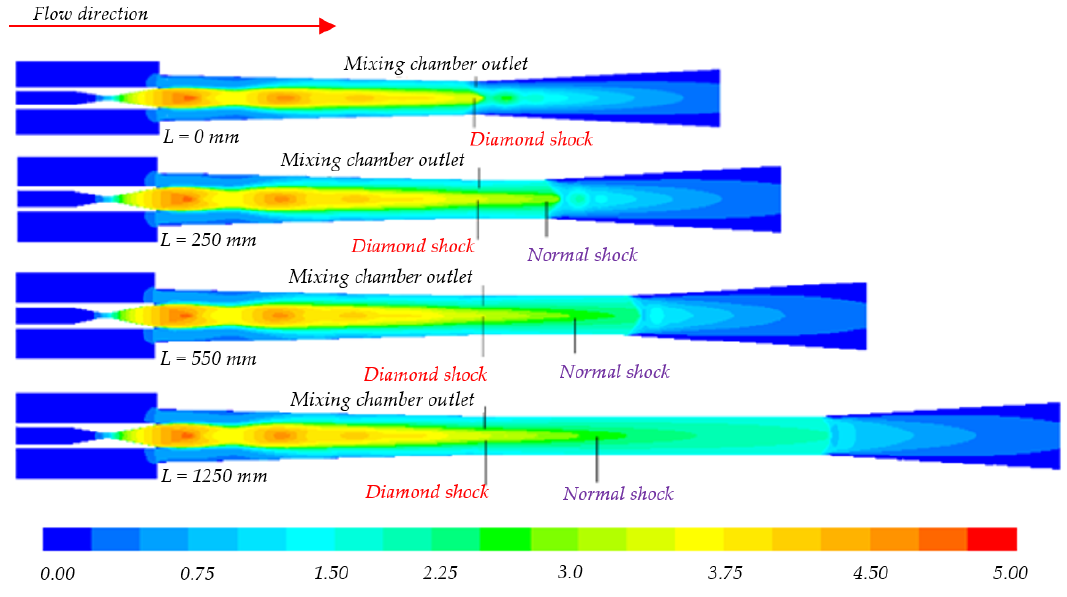
Figure 19. Mach number contour for varying throat length